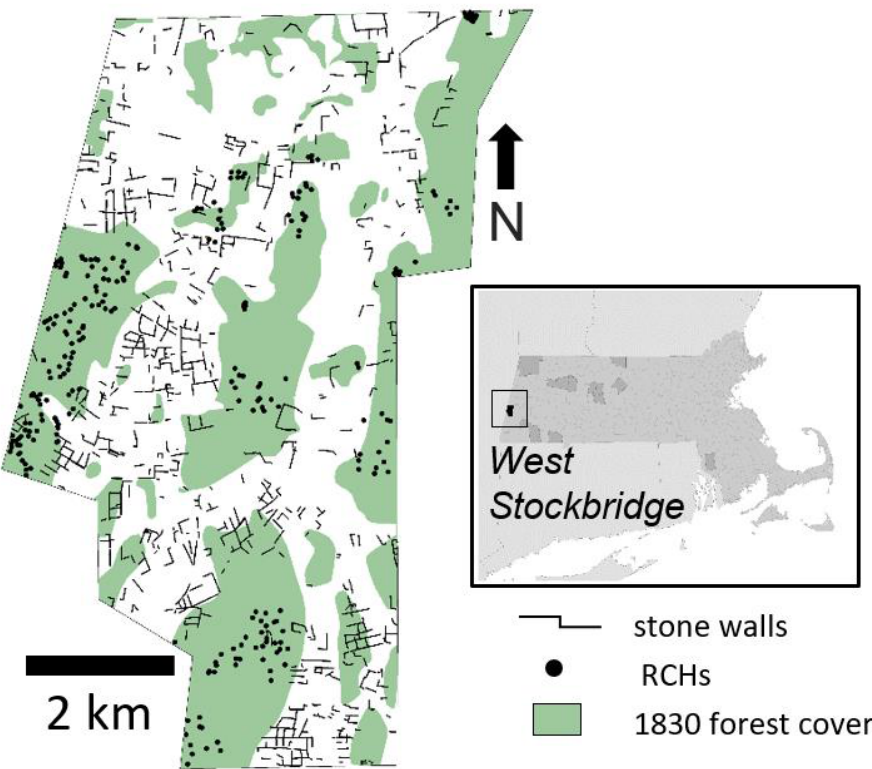
Figure 8. Relict charcoal hearths (RCHs) tend to occur in areas of towns which were typically not well-suited for agriculture, as shown here in West Stockbridge, Massachusetts, where RCHs occur in areas of the town which were forested in 1830. Map projection is NAD 1983 UTM Zone 18N.